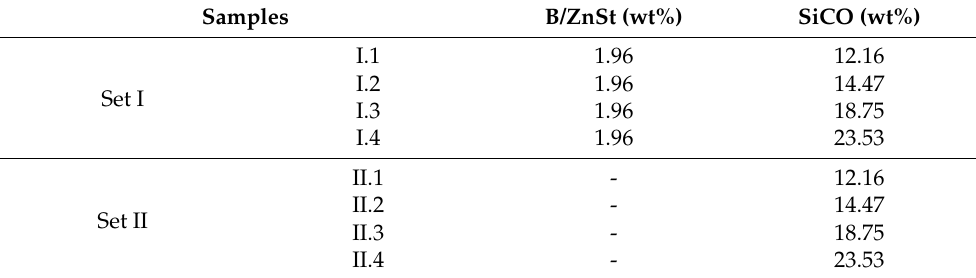
Table 1. Content of anti-rodent samples.